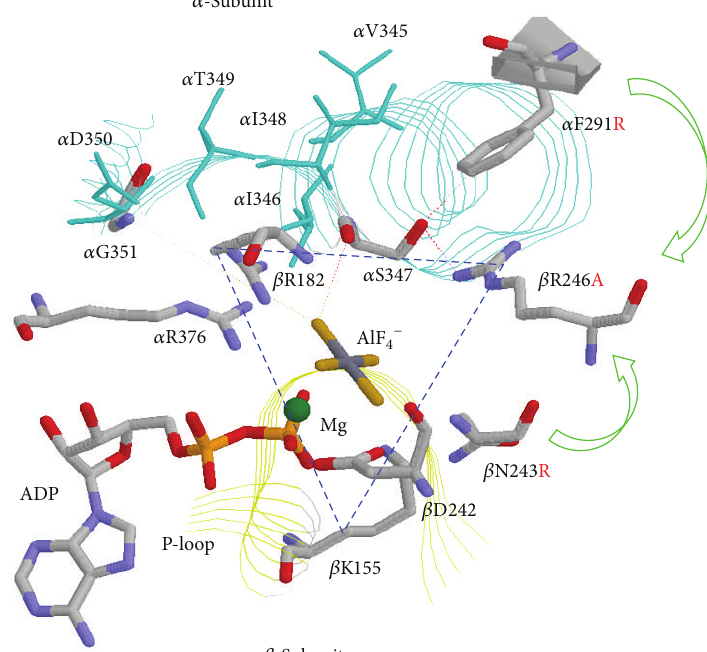
Figure 2: Catalytic sites X-ray structure of ATP synthase depicting spatial relationship between 𝛼 and 𝛽 -subunit residues. The 𝛽 DP site in the AlF 4− -inhibited enzyme structure is taken from [63]. E. coli residue numbering is used. It can be seen that removal of arginine from 𝛽 R246 can be compensated by introduction of arginine in the neighboring residues 𝛼 F291 or 𝛽 N243. Dotted triangle shows the residues 𝛽 Lys-155, 𝛽 Arg-182, 𝛽 Arg-246, 𝛼 Arg-376, and 𝛼 Ser-347, forming a triangular Pi binding site. Figure was modified from the originally published figure in [75]. RasMol molecular visualization software was used to generate the